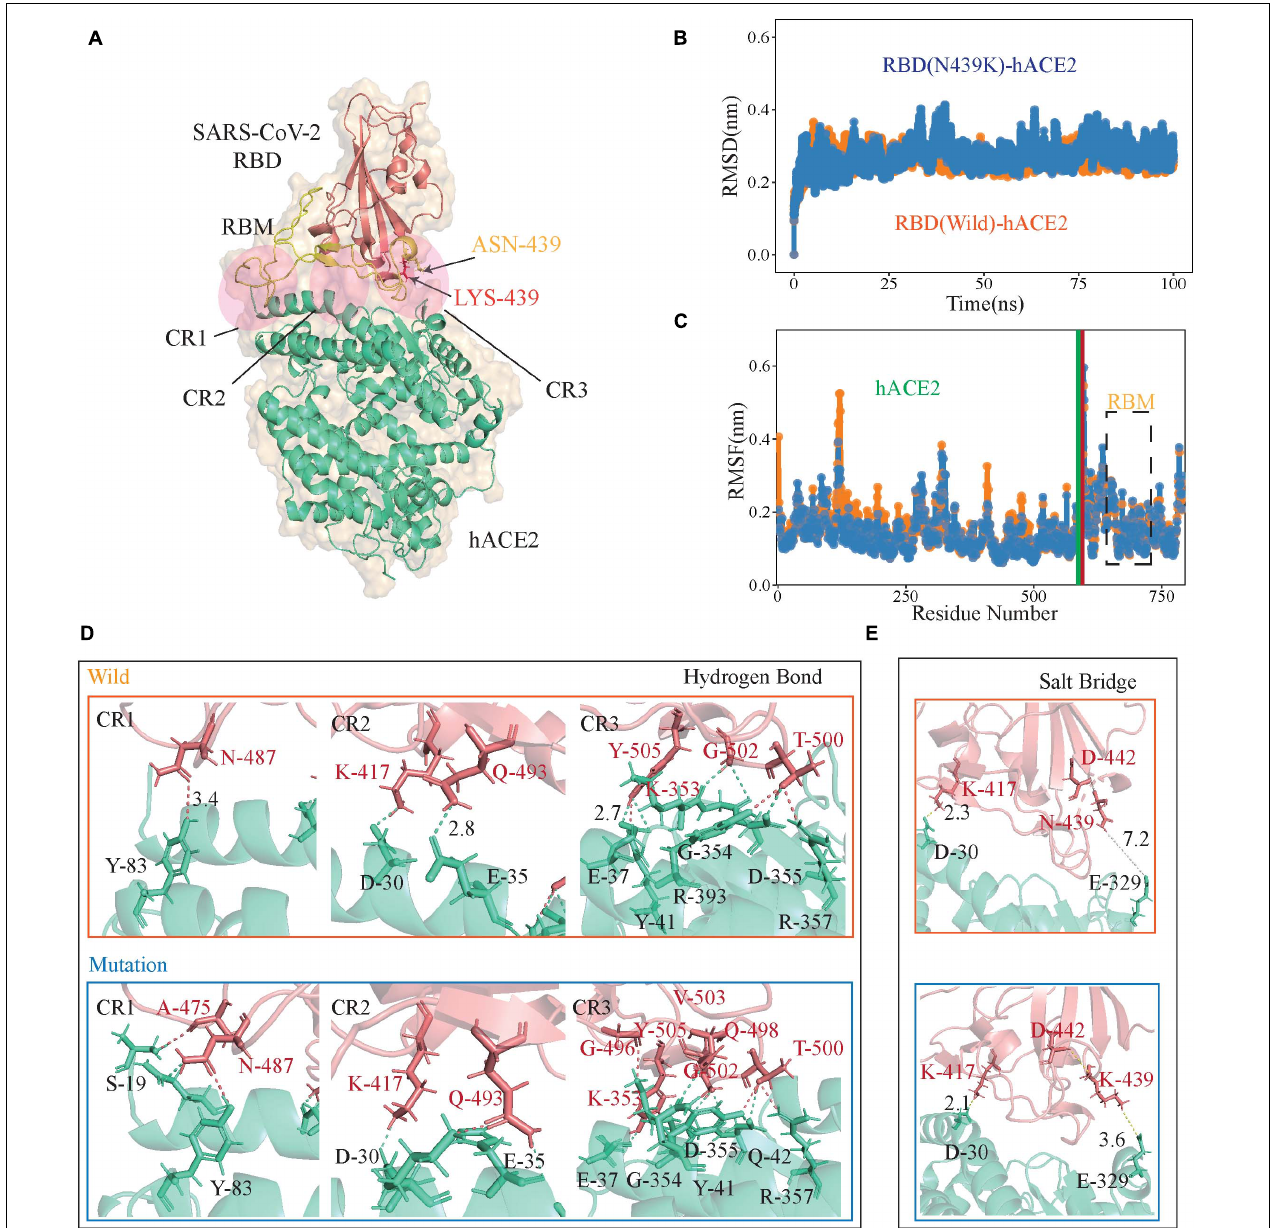
FIGURE 2 | The RBD-hACE2 interaction profile of MD simulations. (A) The structure of SARS-CoV-2 RBD-hACE2 (PDB ID: 6M0J). SARS-CoV-2 RBD core is shown in deepsalmon and its interacting hACE2 is colored greencyan, and RBM of RBD is represented in yellow. Receptor-ligand interface includes the N-terminal (CR1), the central region (CR2) and the binding loop (CR3), ASN439 (yellow) to LYS439 (red) in CR3. (B) The RMSDs of the backbone atoms of both RBD-hACE2 complexes, the RBD-hACE2 is colored orange and RBD(N439K)-hACE2 is colored blue. (C) The RMSFs of C α atoms of both RBD-hACE2 complexes, where RBD-hACE2 is colored orange and RBD(N439K)-hACE2 is colored blue. (D,E) Hydrogen bonds and salt bridges are shown as dotted lines, RBD (deepsalmon), and hACE2 (greencyan) residues are described as sticks, respectively. The orange box indicates wild-type RBD-hACE2 and mutant-type RBD-hACE2 is a blue